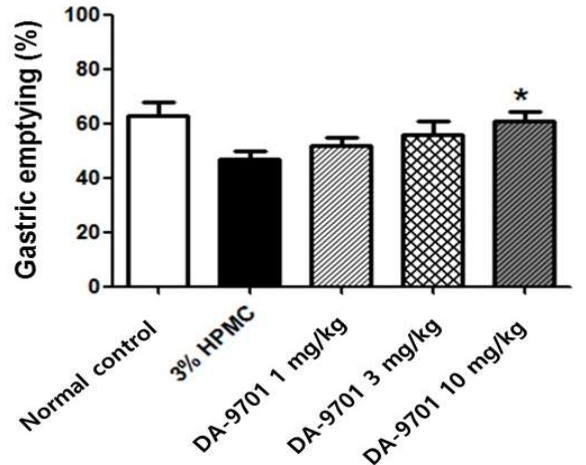
Figure 10. Effect of DA-9701 on gastric emptying in streptozotocin-induced diabetic mice. Gastric emptying was significantly delayed in streptozotocin-induced diabetic mice and improved with DA-9701 in a dose-dependent manner (50 ± 11 %, 55 ± 12%, and 60 ± 11% in 1 mg/kg, 3 mg/kg, and 10 mg/kg of DA-9701 treatment, respectively), compared to the 3% HPMC-treated placebo group. In particular, treatment with 10 mg/kg of DA-9701 significantly improved gastric emptying rate compared to placebo (60 ± 11% vs. 43 ± 10%, * p < 0.05) (n = 10 in each group).